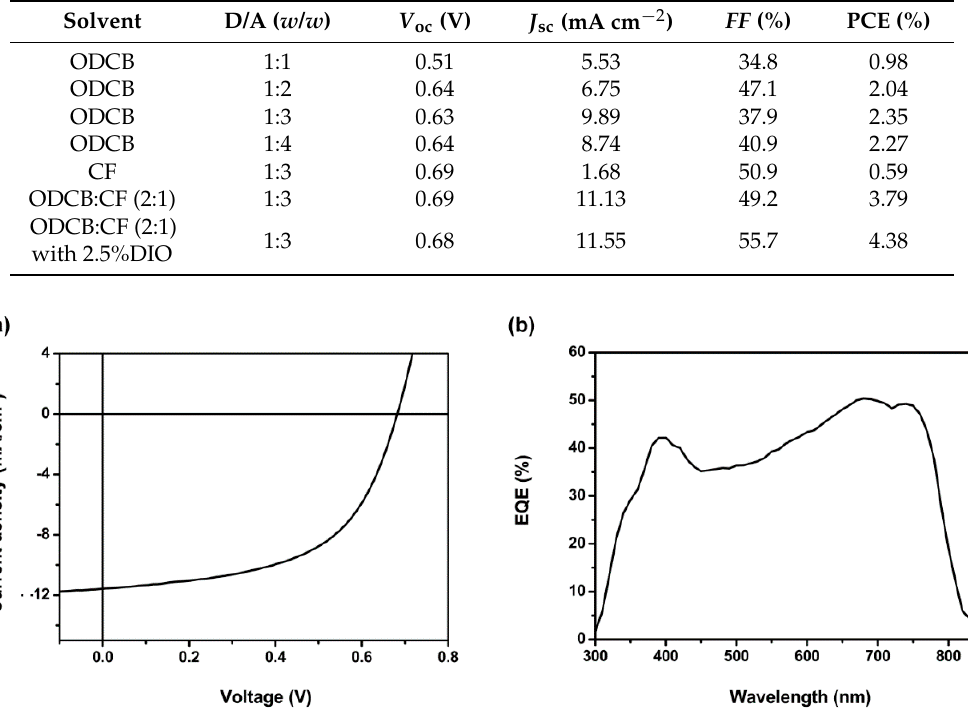
Figure 5. ( a ) J–V curve of PSTDPP based BHJ solar cells prepared under the optimal condition (D/A ratio = 1:3, using O -dichlorobenzene (ODCB) and chloroform (CF) ( v / v = 2:1) with 2.5% DIO as processing solvent); and ( b ) EQE curve of the corresponding device.